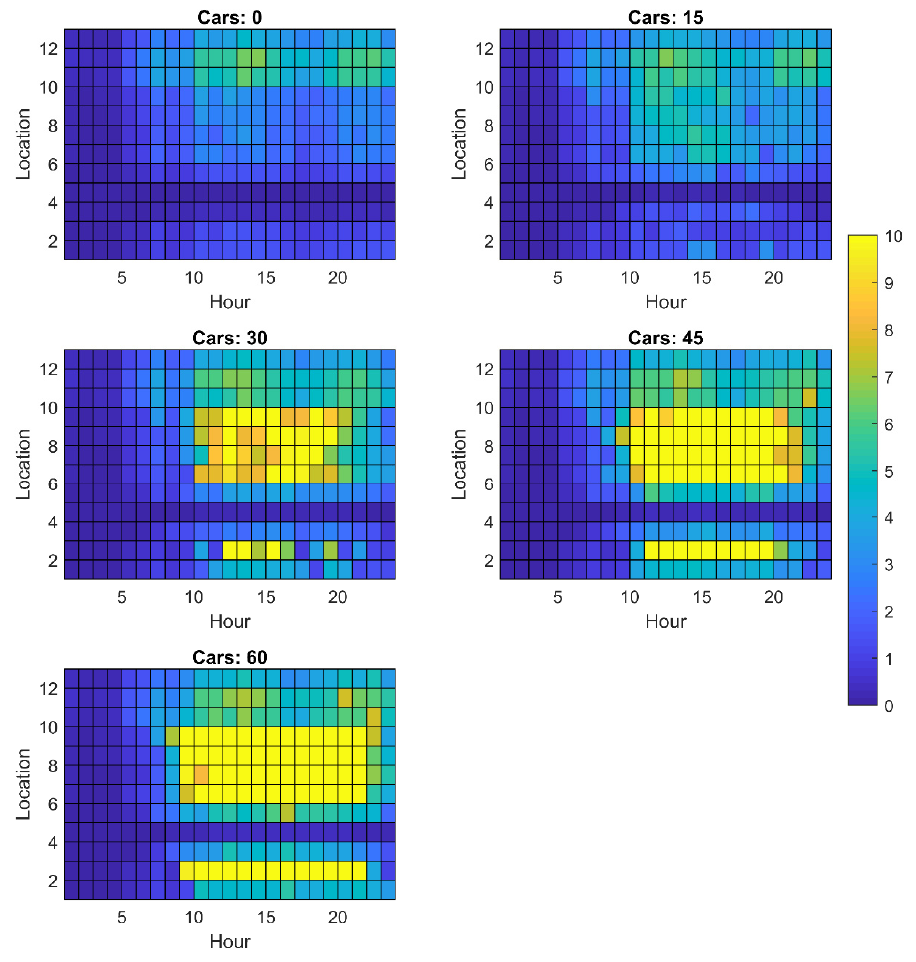
Figure A8. Maximum voltage drops (percentage) observed in network 3 with distributed generation ON.